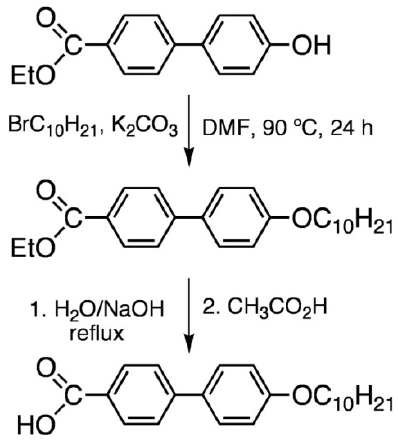
Figure 5. Synthetic route of 4 ′ -decyloxybiphenyl-4-carboxylic acid (10-BPhCOOH).